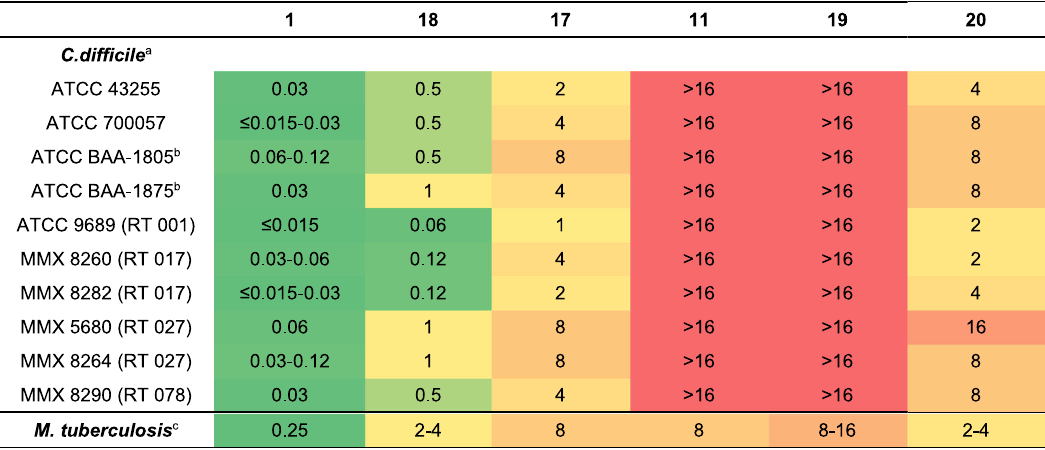
Fig. 13 Minimum inhibitory concentration (MIC) values. Determination of the MIC in µ g/mL against a panel of different C. dif fi cile strains and M. tuberculosis .